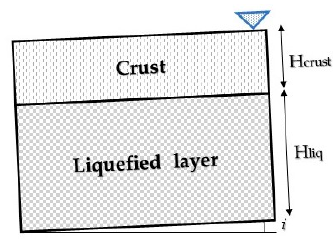
Figure 20. Idealized soil profile used in the parametric study.